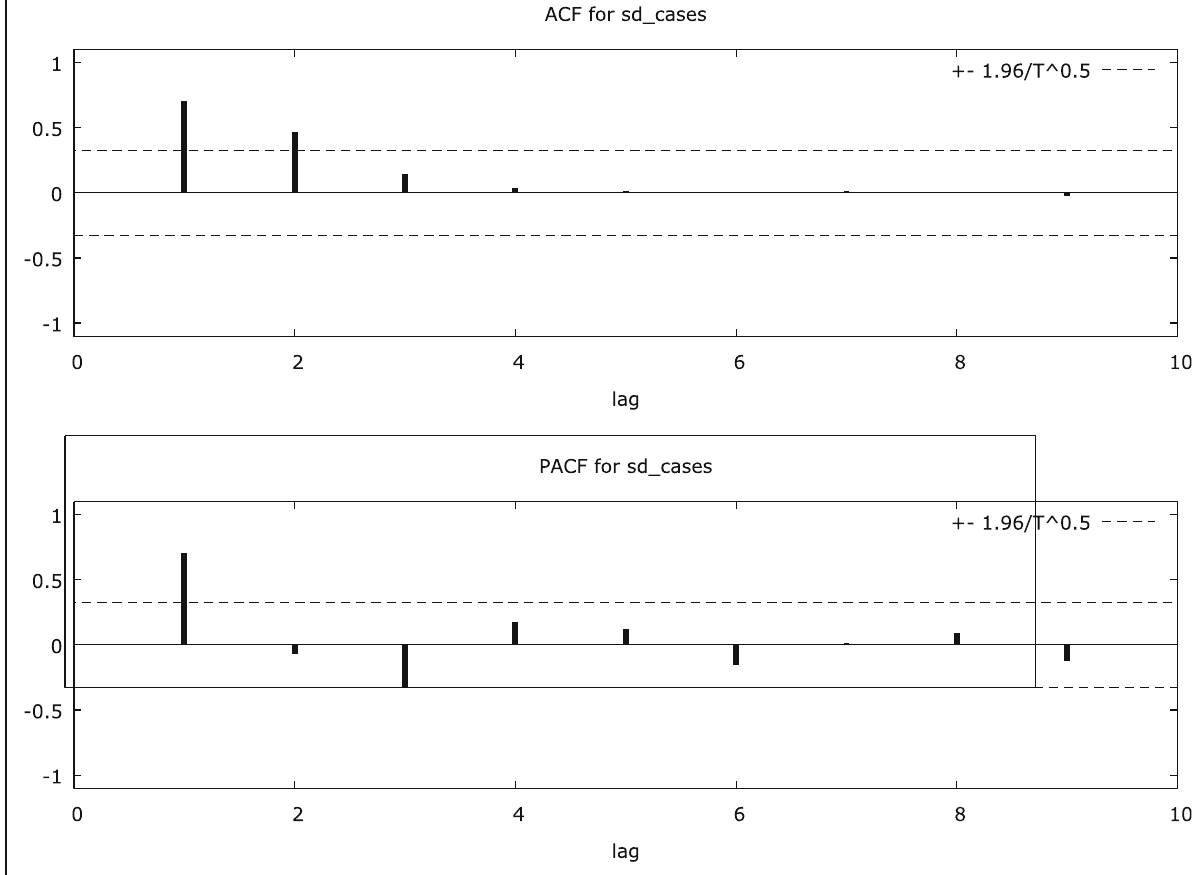
Fig. 5 Correlogram of the seasonally differenced time series of cases of Kyasanur Forest Disease in Goa, India, during 2015 –